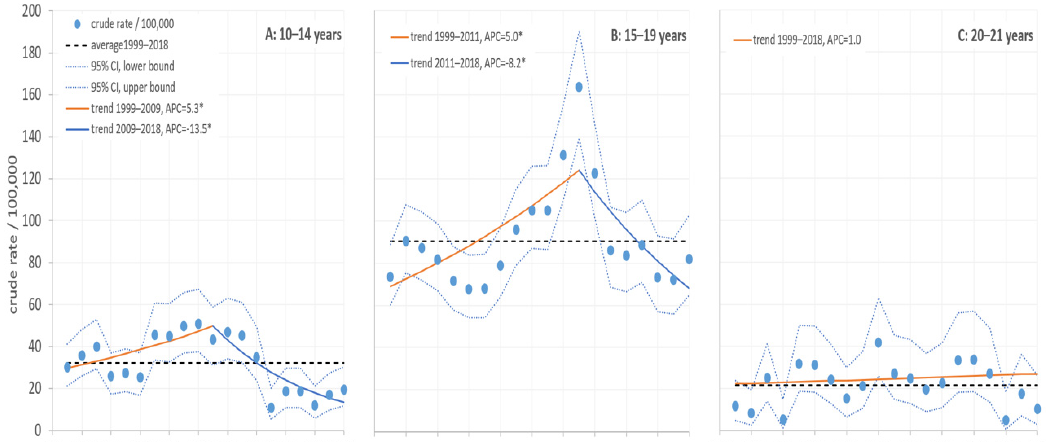
Figure 1. Hospitalization rates ( / 100,0*00) for patients with mental and behavioral disorders due to acute alcohol intoxication (MBDAAI) in Slovenia during the 1999–2018 period.